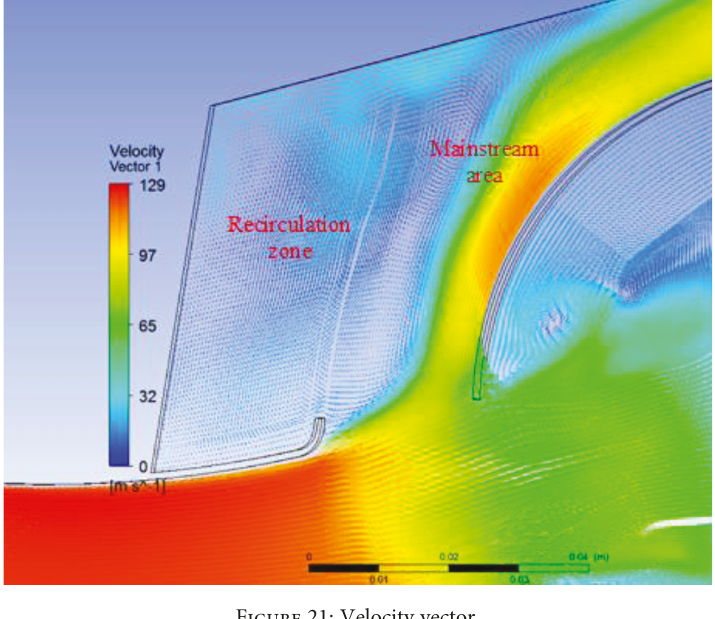
Figure 21: Velocity vector.